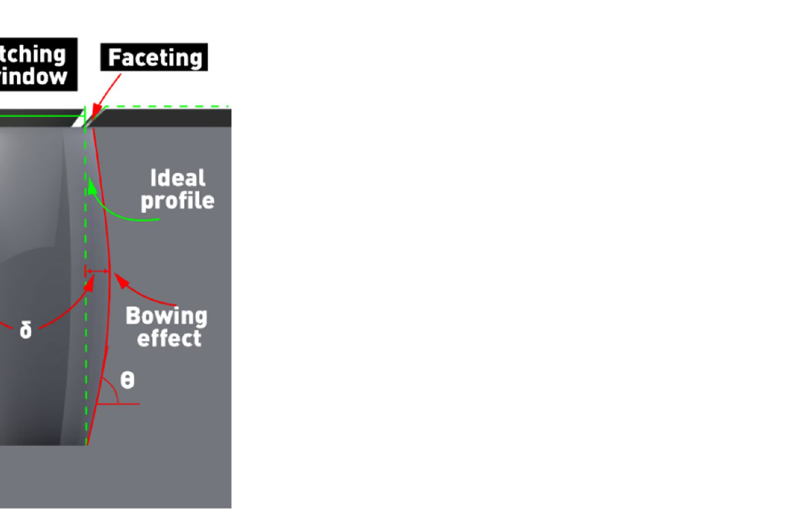
Figure 4. Schematic of measurements of the inclination angle and “bowing effect” of the etched